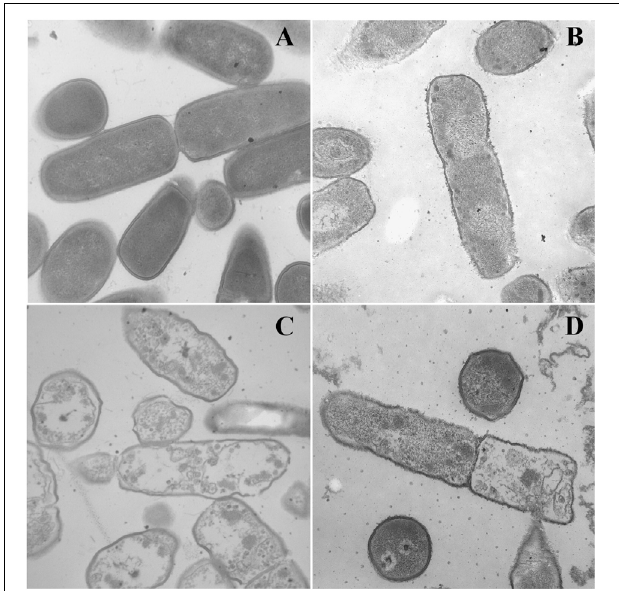
FIGURE 5 | TEM micrographs of E. coli ATCC 25922 treated by peptides at 1 × MICs. (A) Control, (B) dCATH for 60 min, (C) dCATH(1–16) for 60 min, and (D) dCATH(5–20) for 60 min. Control was processed without peptides.